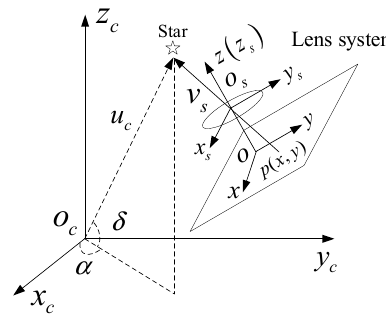
Figure 1. The attitude measurement model of a star sensor.